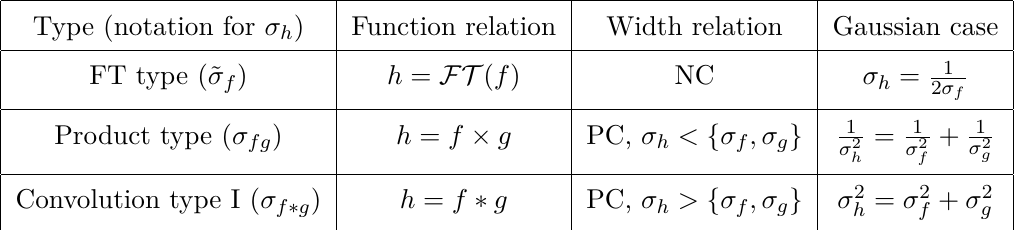
Table 1 . Properties of the width of the function h in terms of the original real function(s) f (and g ). Here NC/PC means that σ h is negatively/positively correlated to σ f (and σ g ).